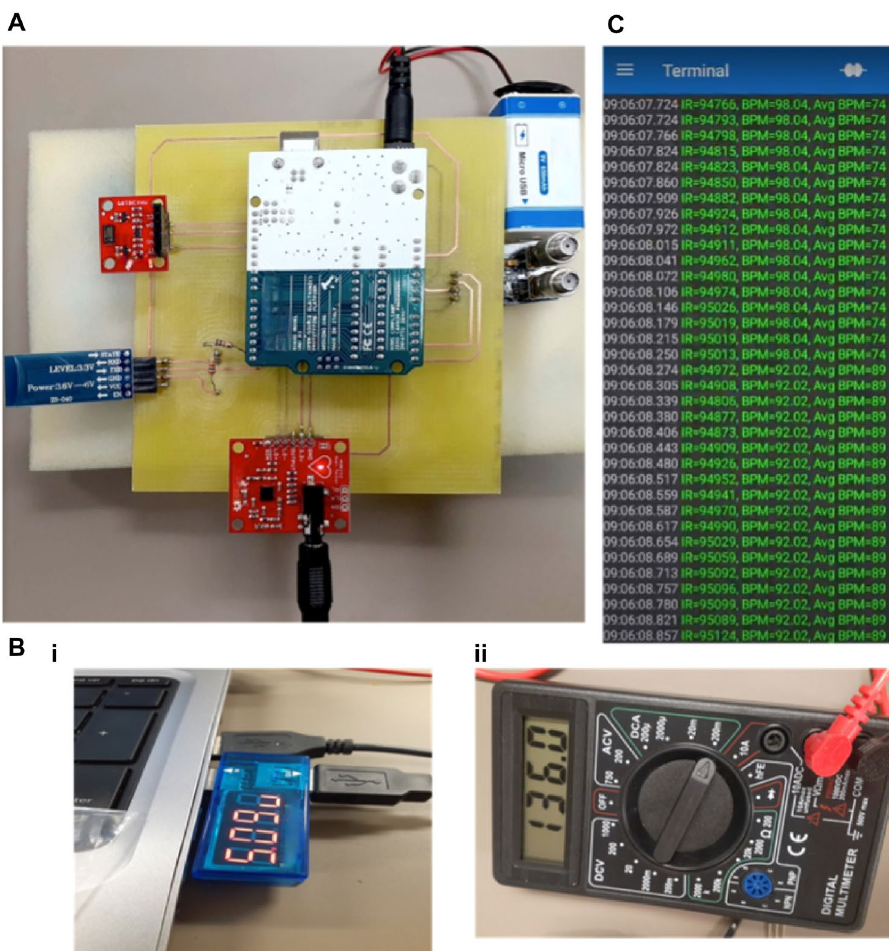
Figure 3. ( A ). HWD for heart failure prediction ( B ). Power specifications of the HWD i. Input voltage of the HWD ii. Current required by the HWD ( C ). Heart Rate in beats per mins being displayed on smartphone using Bluetooth